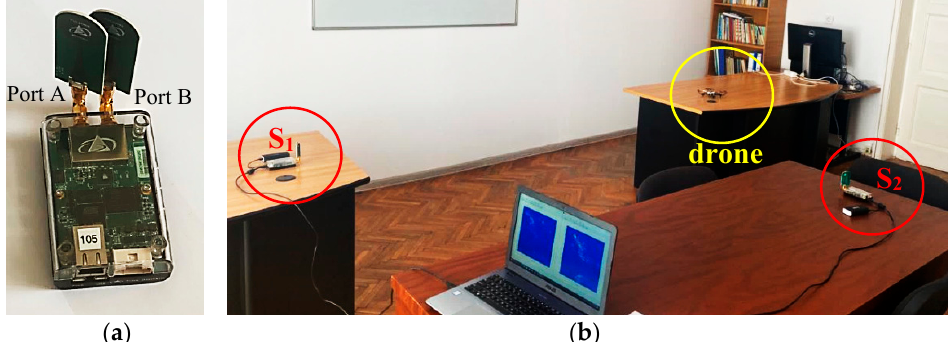
Figure 1. ( a ) The PulsON 440 ultra-wide band (UWB) sensor used for drone movement characterization, ( b ) the sensor placement for the experimental setup.